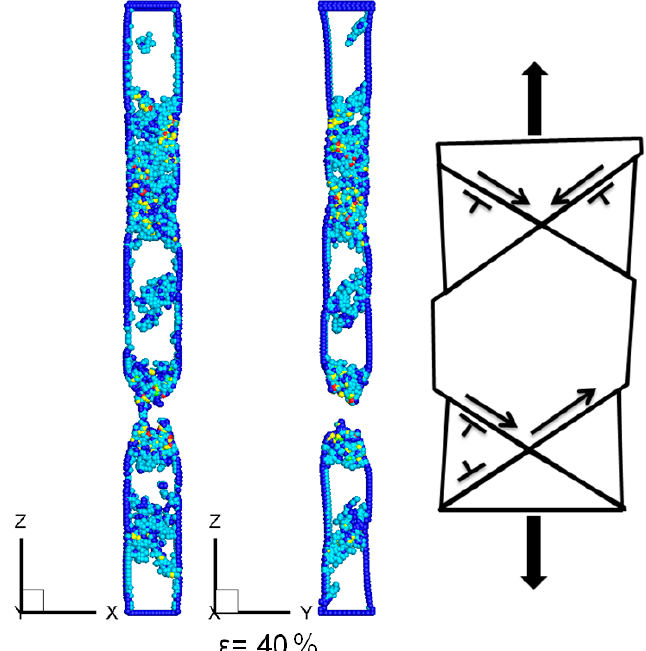
Figure 10. Fracture pattern of (011)-oriented SiNW by tensile stress. (blue: incomplete nanostructure with CN < 4; cyan: CN = 5 meta-stable phase with CN = 5; yellow: Si-II phase with CN = 6; red: high pressure phase with CN > 6).